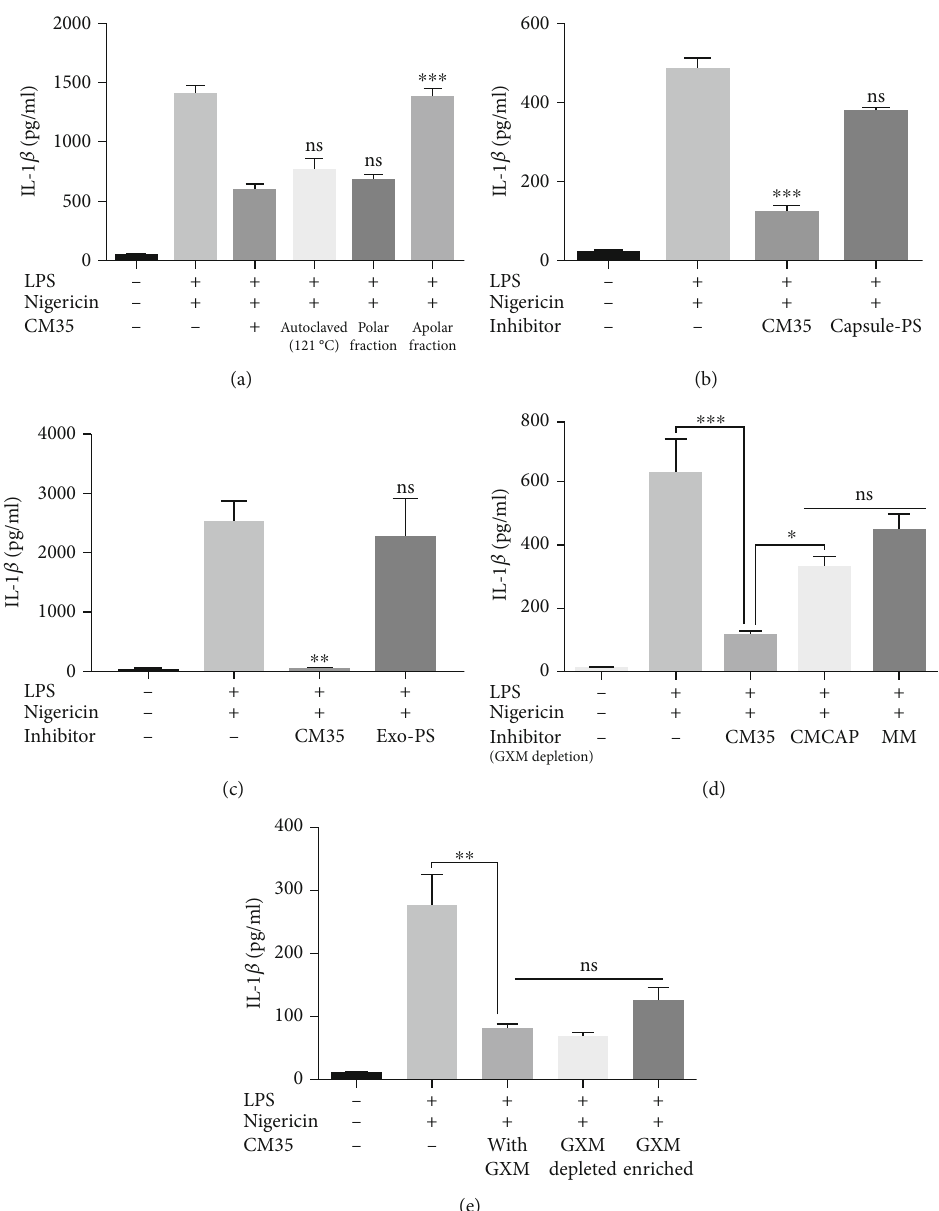
Figure 5: 1kDa CM35 inhibition characteristics indicate a small, polar molecule that does not derive from a polysaccharide origin. (a) BMMs were stimulated with LPS (500ng/ml) and nigericin (20 μ M), with or without 1kDa CM35 fractioned by water a ffi nity or autoclaved (10% v / v ) overnight (18 h). (b, c) BMMs were stimulated with LPS (500ng/ml) and nigericin (20 μ M), with or without potential inhibitor (10% v / v ) overnight (18h). Polysaccharides (200ug/mL) extracted from the (c) capsule or secreted in (d) minimal medium were used as inhibitors. (d, e) BMMs were stimulated with LPS (500ng/ml) and/or nigericin (20 μ M), with or without possible inhibitor (10% v / v ) overnight (18 h). Conditioned medium and minimal media (1 kDa CM35, 1 kDa CMCAP, and MM) were treated for GXM depletion utilizing capture ELISA and used as inhibitors (10% v / v ) (e). GXM recovered from ELISA was mixed with 1kDa CM35 and utilized as an inhibitor (10% v / v ) (f). Supernatants were recovered after stimuli and IL-1 β secretion was quanti fi ed using ELISA. Statistical analysis was performed by one-way ANOVA, where ns: not signi fi cant; ∗ P ≤ 0 : 033 ; ∗∗ P ≤ 0 : 002 ; ∗∗∗ P ≤ 0 : 001 . Comparisons were made with the (a) 1 kDa CM35- treated group or the (b, c) positive control group